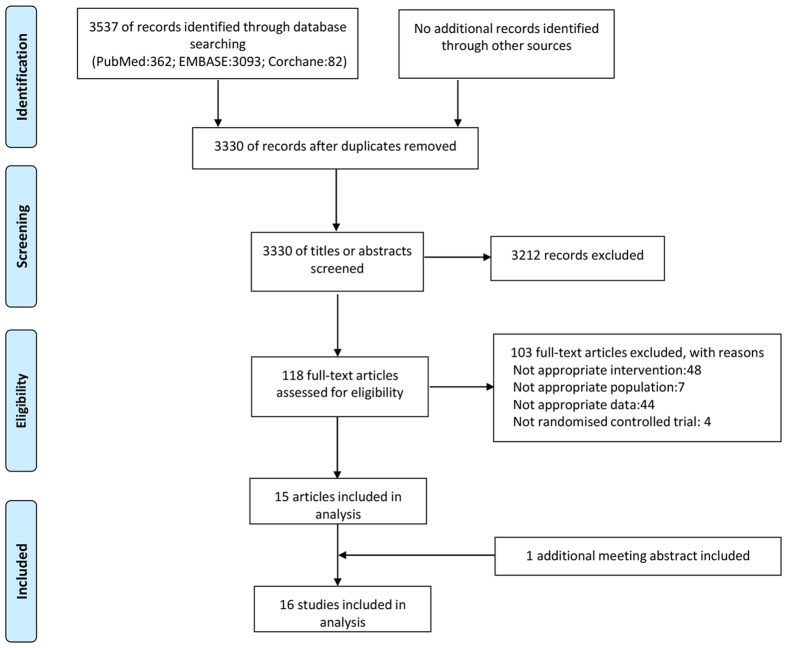
Flowchart of article selection.